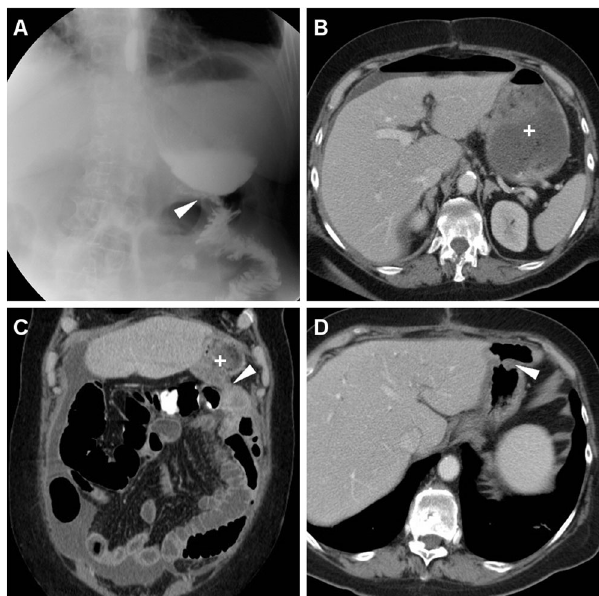
Fig. 10 A 77-year-old female with distal gastric carcinoma underwent partialgastrectomy. Early postoperative CF(A) showedslowemptyingof gastric remnant through the GJS (arrowhead), without appreciable extraluminal leaks. Six days later, the patient suffered from high fever: contrast-enhanced CT (B-C) showed dilated remnant stomach (+), absence of collections adjacent to the GJS (arrowheads in C and D), but persistent intraperitoneal air and fluid consistent with peritonitis, confirmed at surgical exploration: after redo anastomosis, the final status of GJS (arrowhead) is shown in